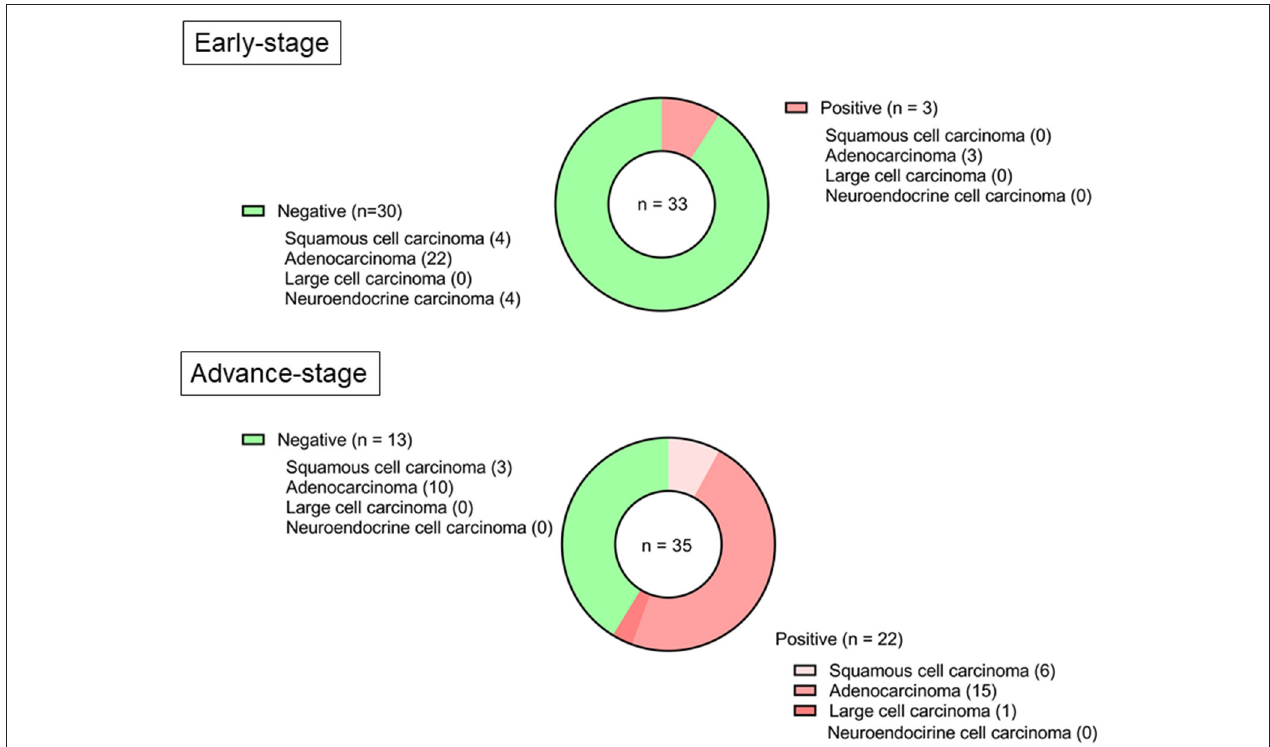
FIGURE 2 | Frequency for TNNT2 immunoreactive staining in specimens with early-stage lung cancer (Stage 0–I) and advance-stage lung cancer (Stage II–IV and recurrence).